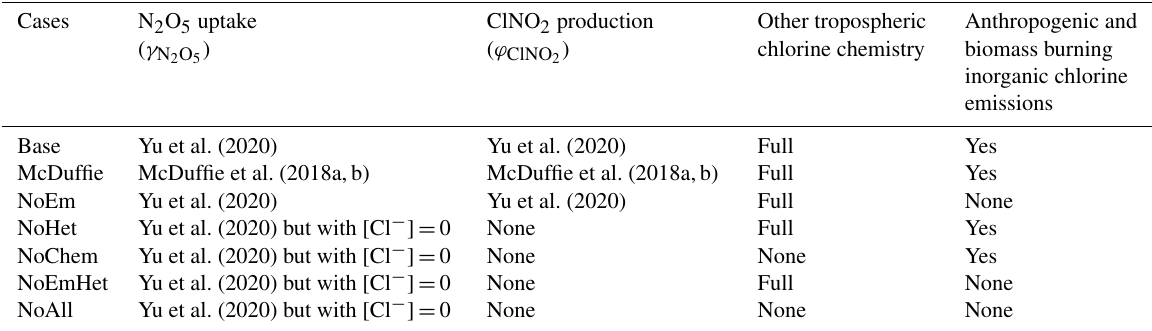
Table 2. Model setup of all simulation cases.